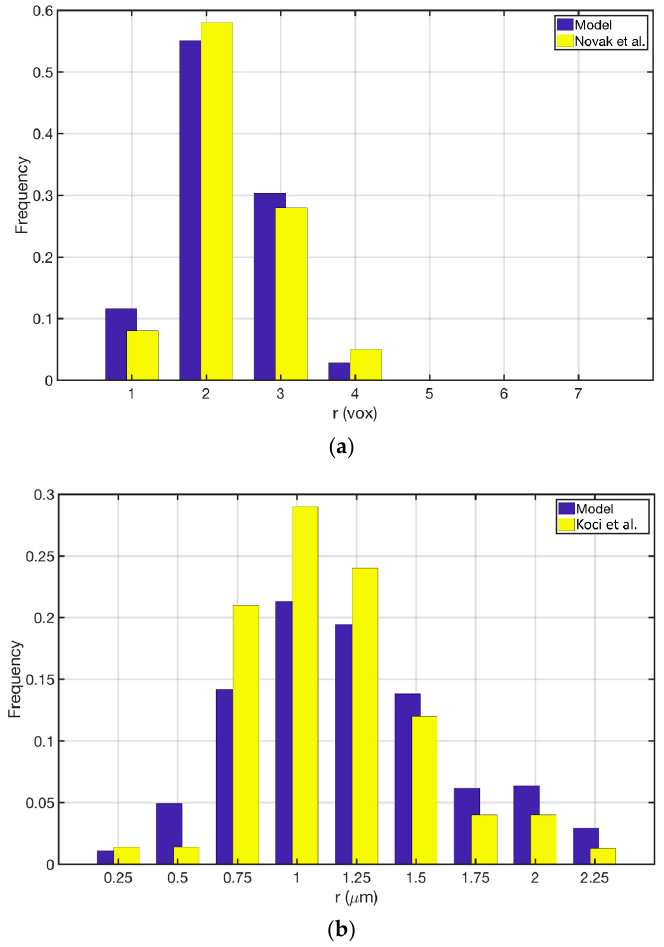
Figure 3. Comparison of the pore size distribution between the current study and: ( a ) Novak et al., 2010; ( b ) Koci et al., 2010.